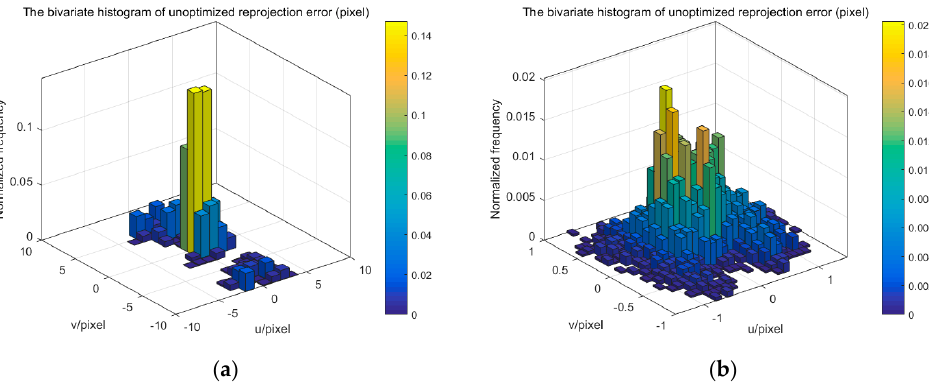
Figure 14. The reprojection error of one camera. ( a ) unoptimized; ( b ) optimized. Table 2. The relative extrinsic parameters of the four-camera system.